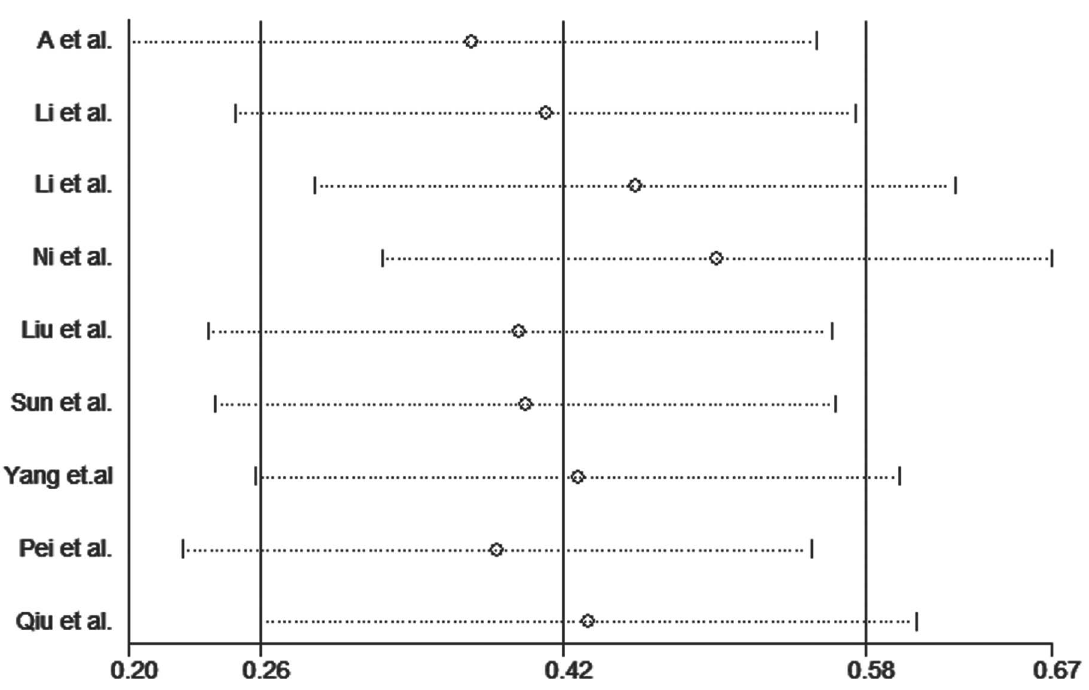
Fig 8. Sensitivity analysis diagram for each study used to assessthe relative risk estimates for the MTHFR C677T polymorphism and male infertility in all of the included studies. (dominant model: TT + TC vs.